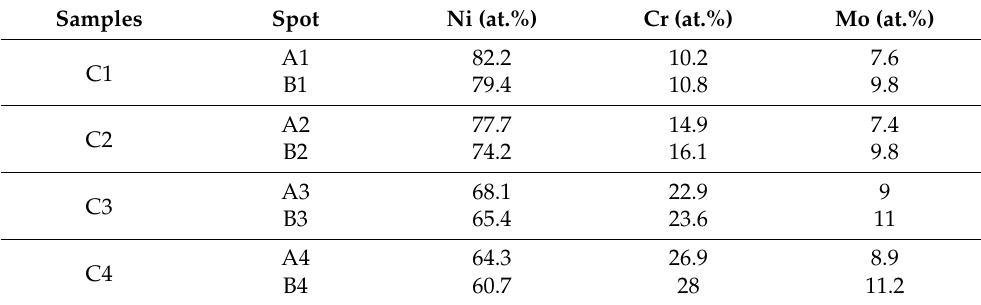
Figure 1. SEM micrographs of Ni–xCr–Mo coatings with varying Cr contents: ( a ) C1, ( b ) C2, ( c ) C3, and ( d ) C4. Table 3. Element content for typical phases of Ni–xCr–Mo coatings displayed in Figure 1.